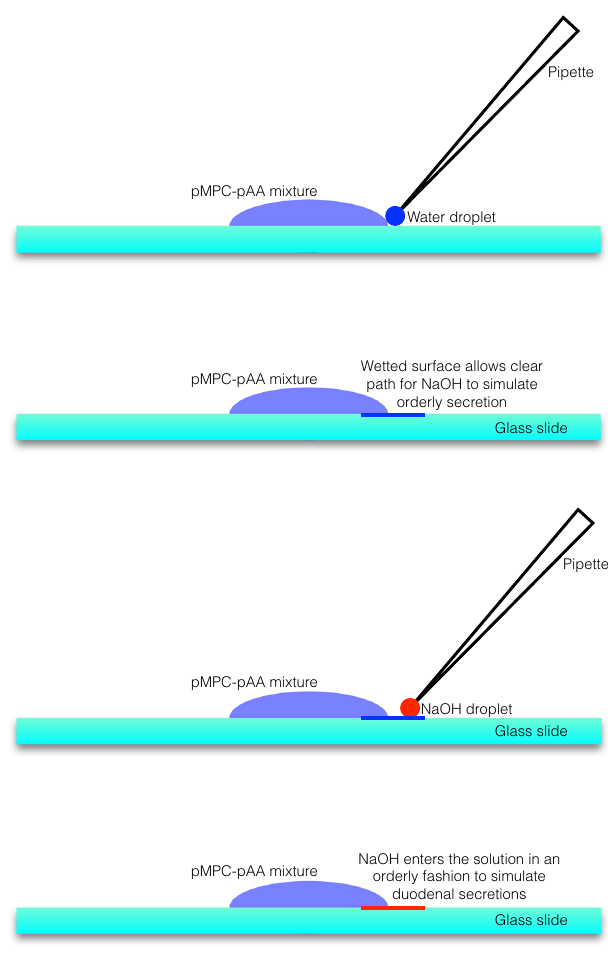
Fig. 9 Physical simulation to expose pZCs to physiological conditions relevant to the duodenum. Addition of water to the edge of the droplet (top, blue dot) allows wetting of glass surface along a line near the circumference of the pZC mixture (depicted as a blue line). Next, a small volume of NaOH solution (red dot) is micropipetted at the edge of the wet line created previously. This system in turn promotes the orderly movement of NaOH into the polymer mixture unidirectionally and